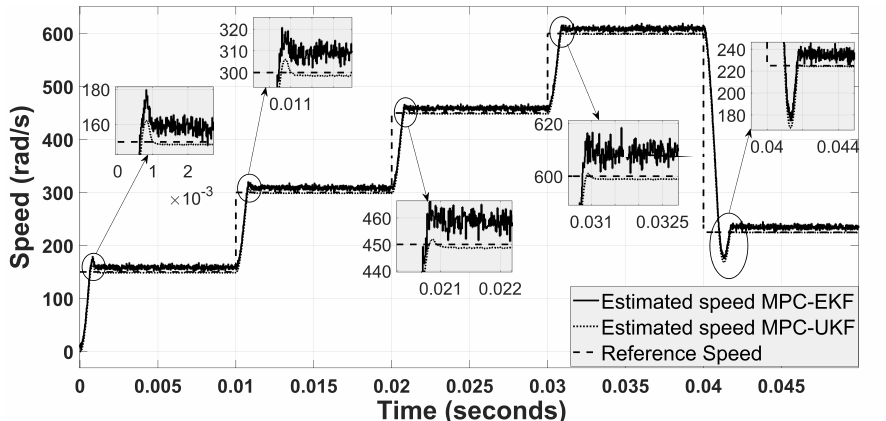
Figure 12. Speed estimation comparison of MPC-UKF and